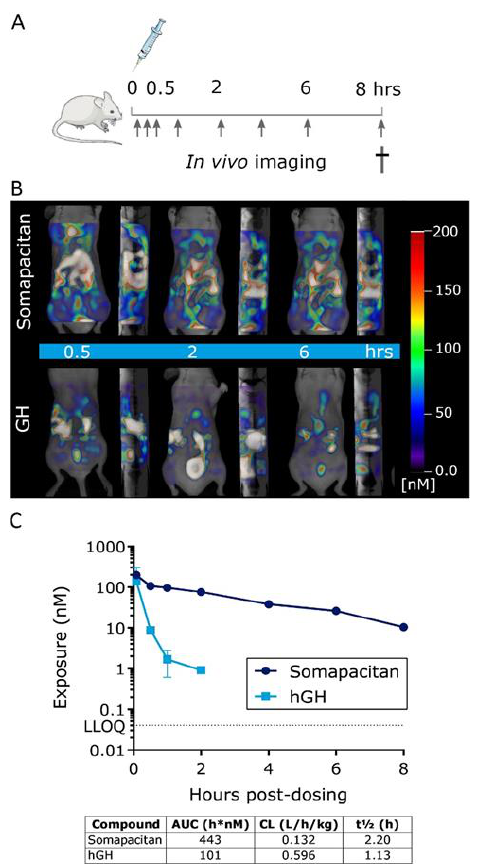
Figure 4. GH and somapacitan show district temporal patterns of biodistribution in mice. ( A ) Schematic illustration of the in vivo study design, arrows indicate fluorescent imaging time points post-dosing. ( B ) Representative frontal and sagittal images of the same animals showing the longitudinal biodistribution of somapacitan and GH at 0.5, 2, and 6 h post iv administration of 60 nmol / kg. Scale bars of fluorescent intensities are included for reference with the highest signal given in white-reddish (200 nM) and lowest intensity depicted in blue (~50 nM). ( C ) Plasma exposure analysis of somapacitan and GH analogs presented on a logarithmic scale. LLOQ: Lower limit of